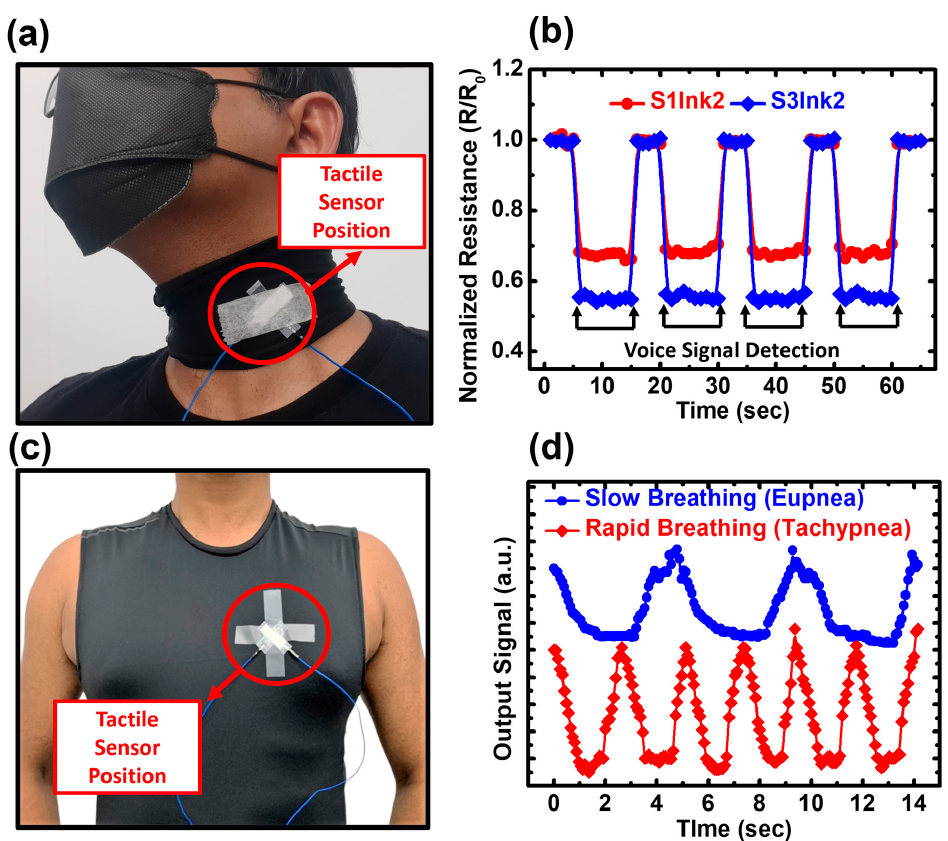
Figure 8. Demonstration of wearable applications to detect human vital signs ( a ) measurement setup of voice activity detection test in presence of background noise and ( b ) recorded speech pattern for 4 cycles. ( c ) Measurement setup of breathing pattern detection test and ( d ) recorded breathing pattern with two distinct natures i.e., eupnea and tachypnea.